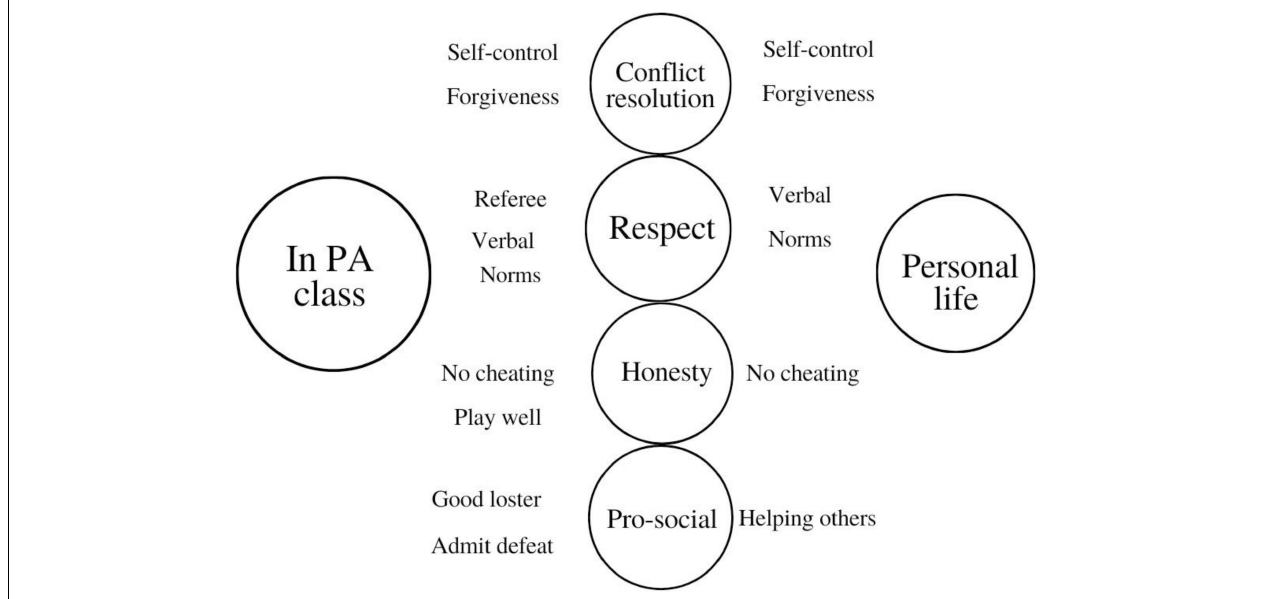
FIGURE 1 | Opinions of participants: Categories of qualitative